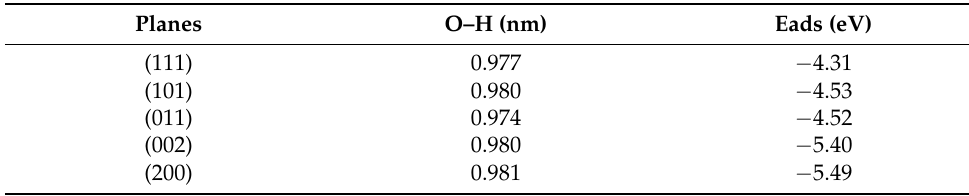
Table 1. The adsorption energy obtained using the first-principles calculation.